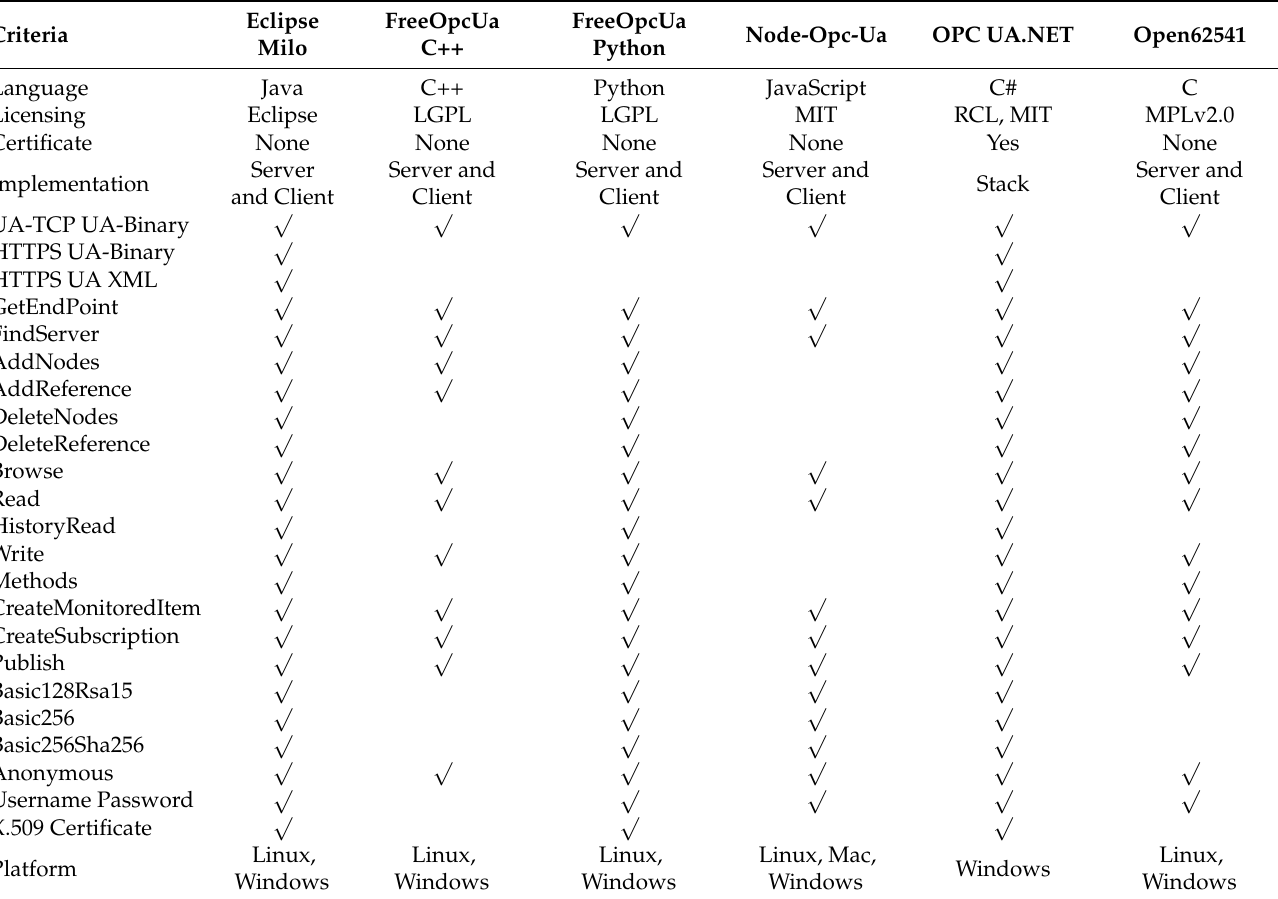
Table 1. Key specifications of some popular OPC UA protocol